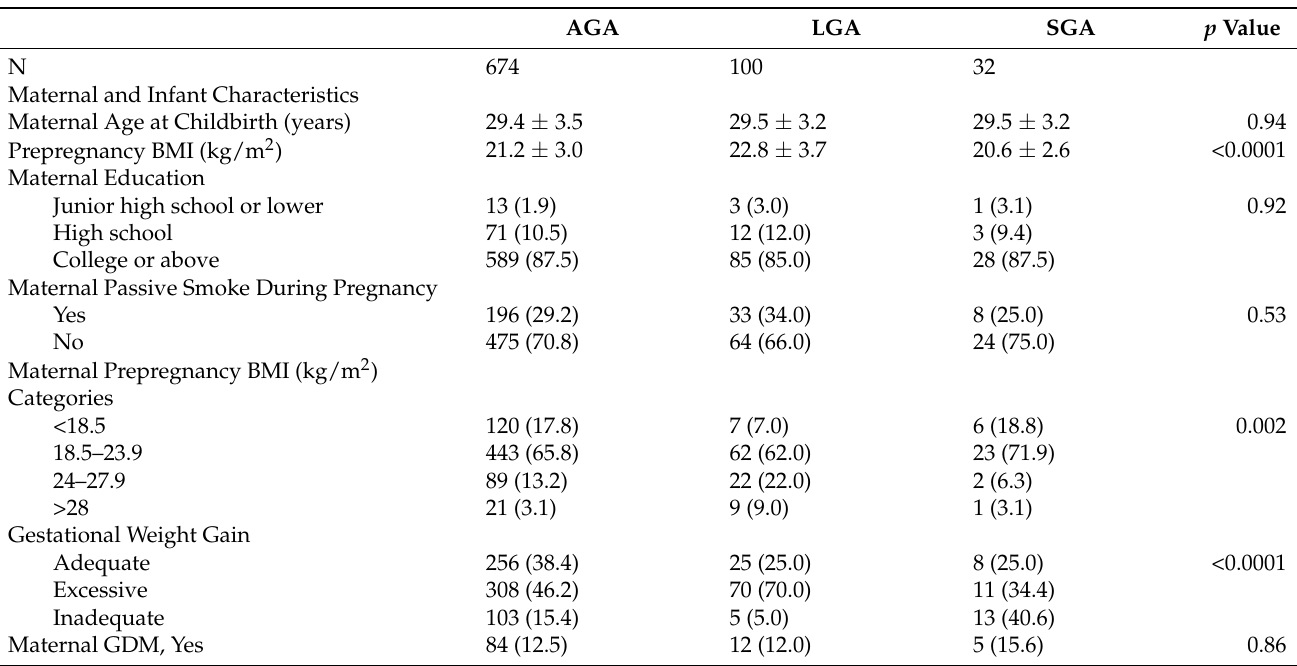
Table 1. Maternal and child characteristics by birthweight for gestational age status (AGA, SGA, and LGA) in 806 term-born